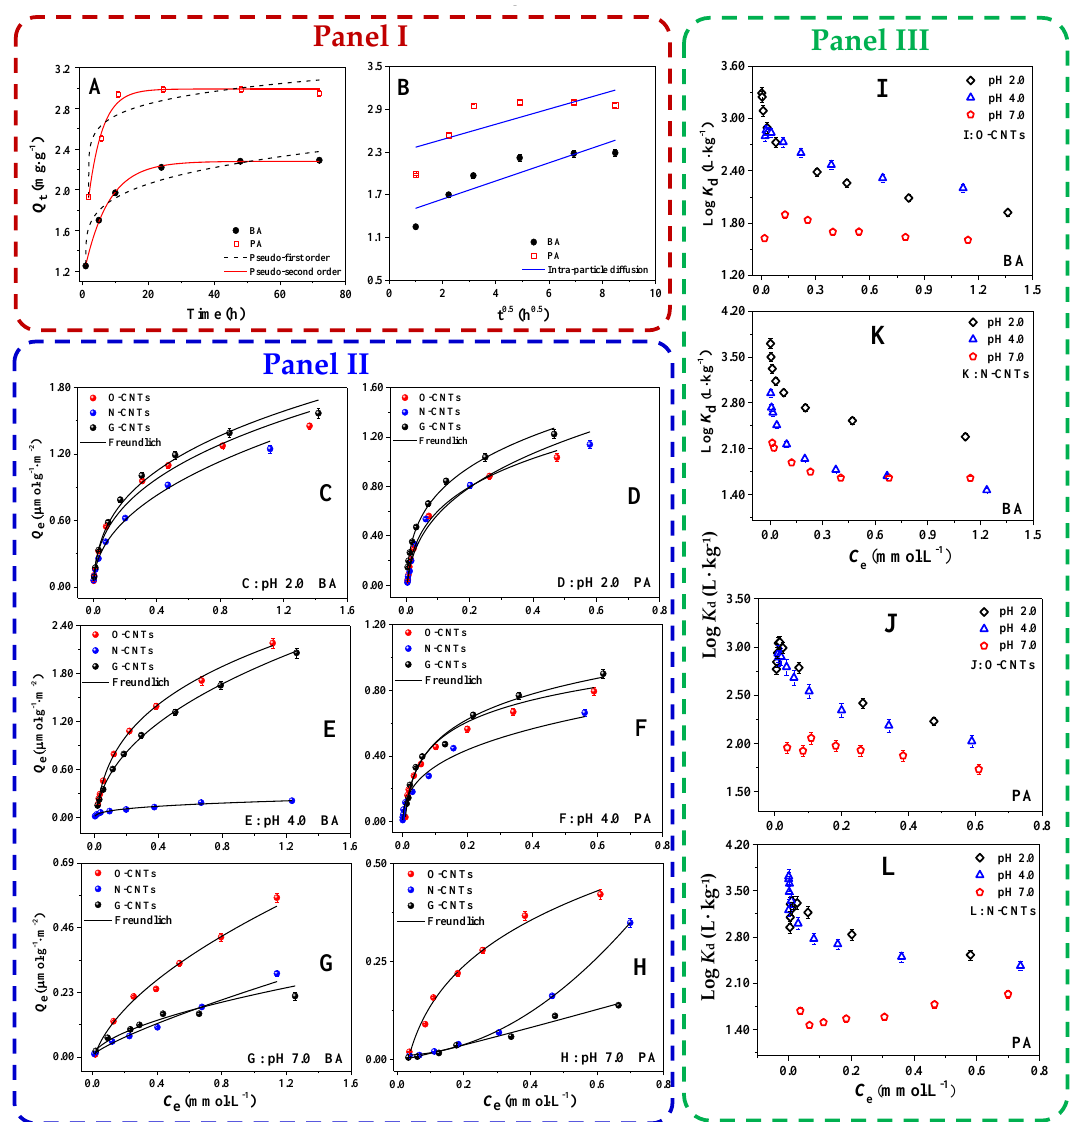
Figure 2. Panel I: The fitting results for ( A ) pseudo-first order, pseudo-second order and ( B ) intra-particle diffusion kinetic models of BA and PA on O-CNTs. Cinitial = 50 mg·L -1 , pH = 7.0, T = 25 ℃ , m/V = 0.625 g·L -1 , contact time = 72 h. Panel II: Adsorption isotherms of BA ( C, E, G ) and PA ( D, F, H ) on CNTs at different pHs after surface area normalization. Panel III: Log K d values of BA ( I, K ) and PA ( J, L ) on O-CNTs and